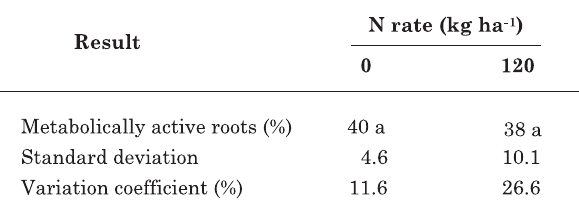
Table 7. Percentage of metabolically active roots of the total mass found at sugar cane harvest, in terms of nitrogen fertilization at